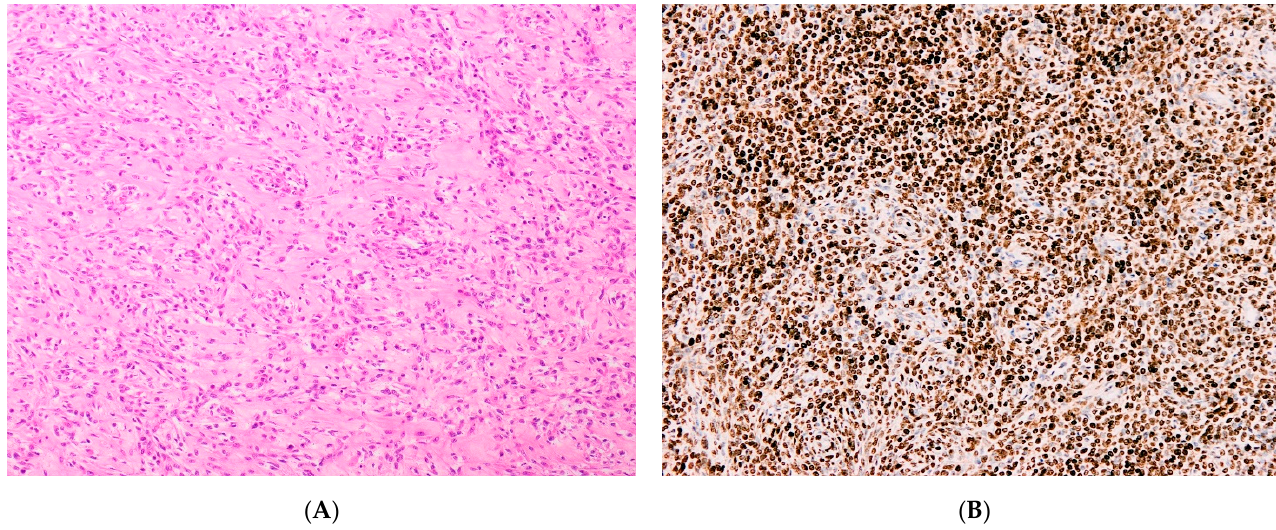
Figure 7. ( A ) The fibro-collagenous low-grade spindle cell component in YWHAE-NUTM2 sarcoma. ( B ) The positive nuclear Cyclin D1 immunostaining in the round cell component of YWHAE-NUTM2 sarcoma.